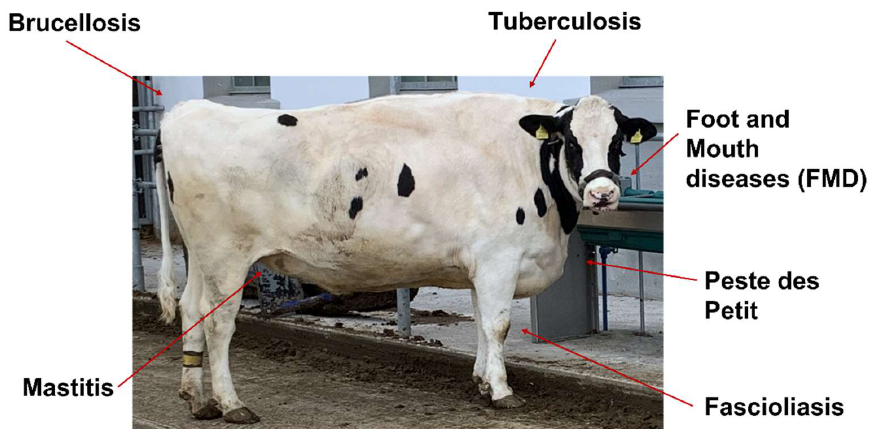
Figure 1. Important infectious diseases in Cows that are known to be at least partially regulated through miRNA